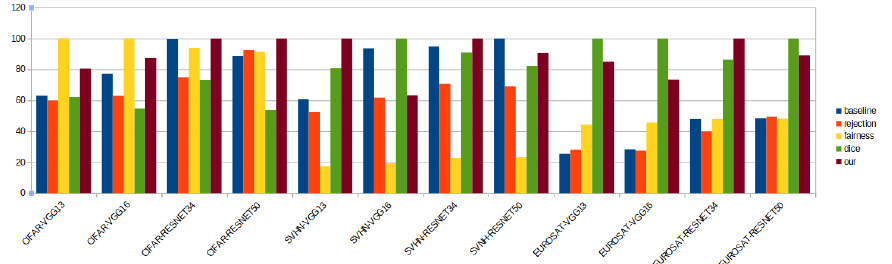
Figure 3. Relative performance of the different methods summarized in a graphic: one can see that the offered method is always either the best (100%) or nearly the best method, while other methods have worse average performance.